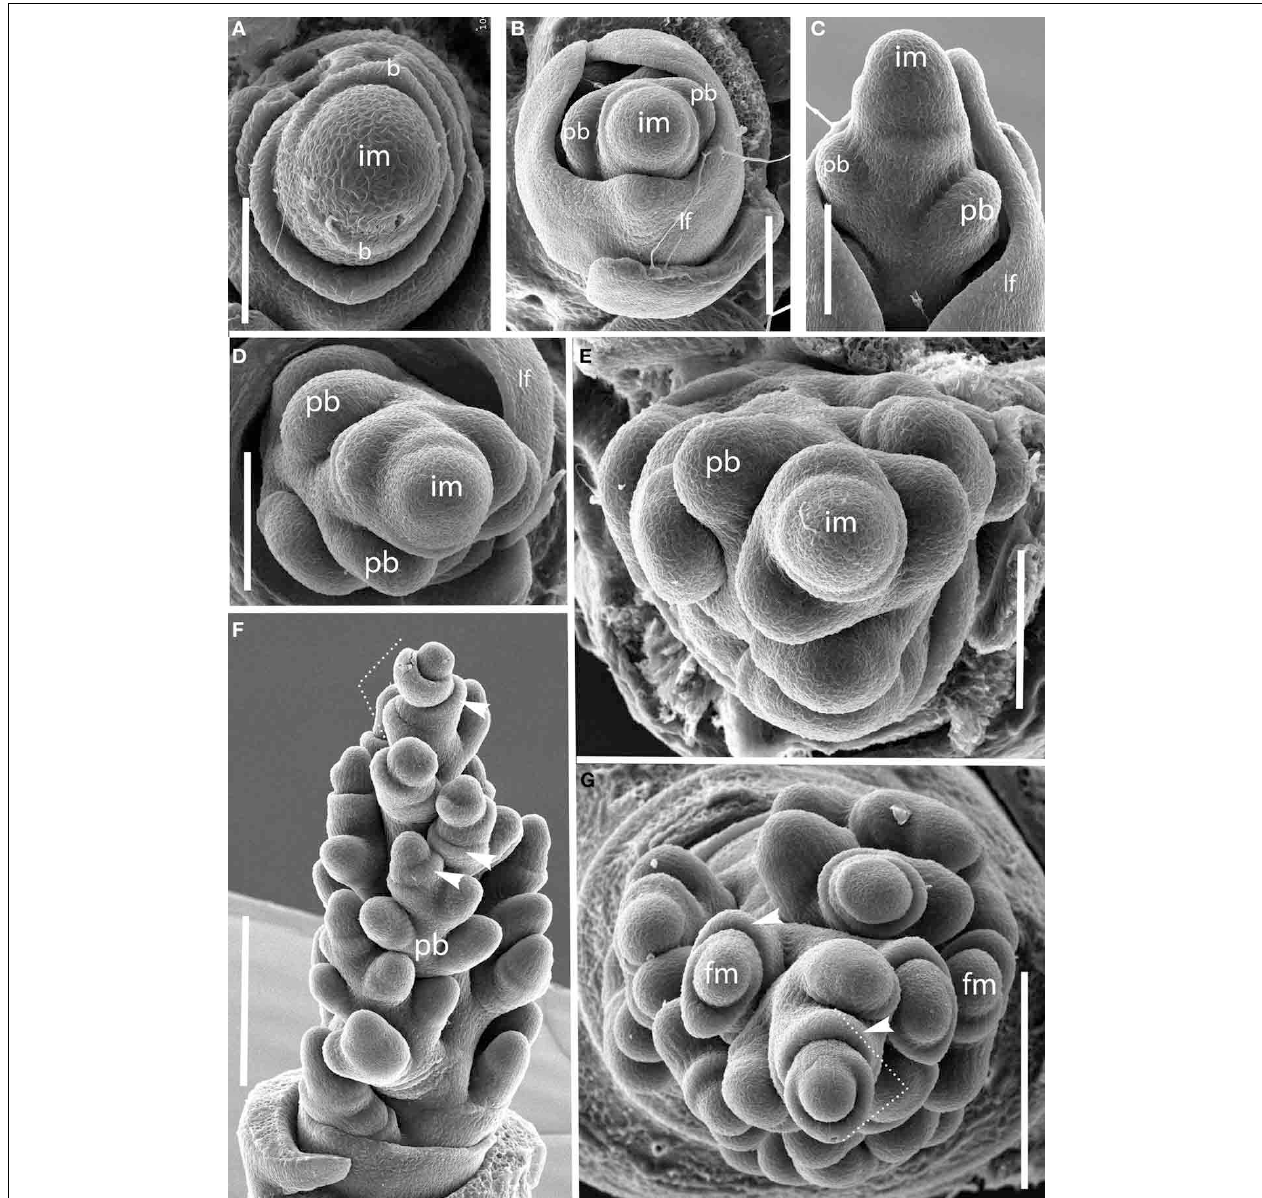
and lemmas, showing terminal spikelet (dotted lines). b, bract; fm, floral meristem; im, inflorescence meristem; lf, leaf; pb, primary branch; arrows, glumes. Scale bars: (A–E) , 100 µ m; (F) , 250 µ m; (G) , 200 µ m.